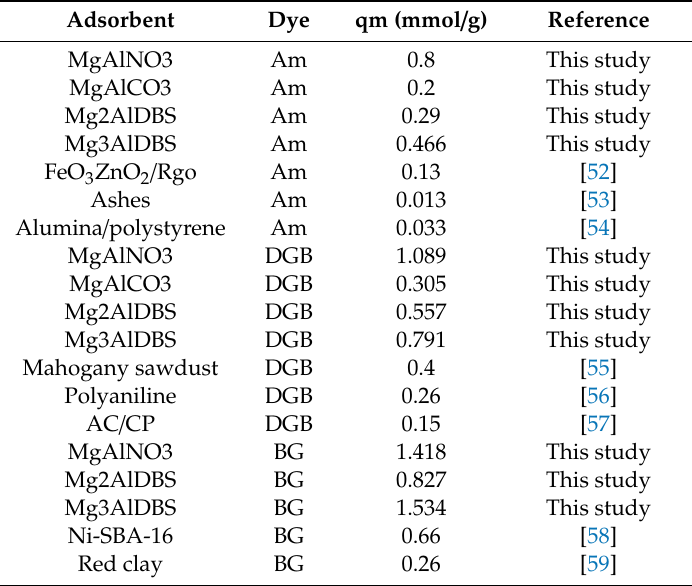
Table 8. Maximum adsorption capacity of several adsorbents used to remove the dyes Am, DGB and